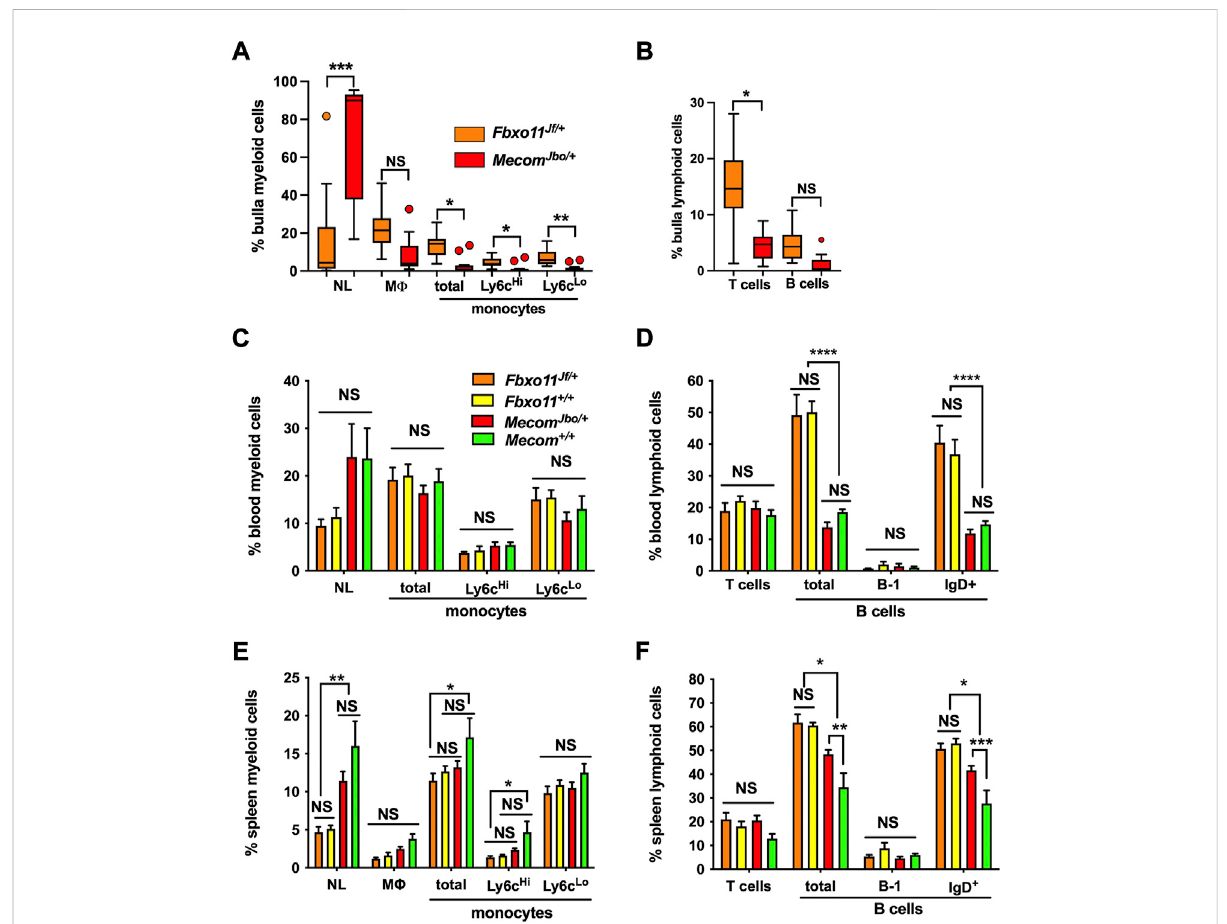
FIGURE 2 FACS analysis of bulla fl uid, blood and spleen WBC. (A,B) Bulla fl uids (C,D) blood and (E,F) spleen. (A) Bulla fl uids in Mecom Jbo/+ mice have a signi fi cantly higher percentage of neutrophils than Fbxo11 Jf/+ mice, whereas Fbxo11 Jf/+ mice have higher total monocytes, higher Ly6c Hi and Ly6c Lo monocyte subsets and (B) higher T cells than Mecom Jbo/+ mice. Data in A and B are for n = 14 Fbxo11 Jf/+ and n = 12 Mecom Jbo/+ bulla fl uids and are represented by box-and-whisker plots, with outlier vales represented by points, and analysed in a series of Kruskal – Wallis tests followed by Dunn ’ s multiple comparison tests (see statistical analysis for details). (C) Blood myeloid and (D) lymphoid cells. Within mouse strains, myeloid and lymphoid cells are not signi fi cantly different in Mecom Jbo/+ and Mecom +/+ comparisons, and in Fbxo11 Jf/+ and Fbxo11 +/+ comparisons. There were genetic background strain differences between Fbxo11 and Mecom leukograms; Fbxo11 mice had higher total B lymphocytes and IgD + B subset populations. (E) Spleen myeloid and (F) lymphoid cells. Within mouse strains, Mecom Jbo/+ mice had higher total splenic B lymphocytes and IgD + B subsets than Mecom +/+ mice. All other myeloid and T cells comparisons in Mecom Jbo/+ and Mecom +/+ , and in Fbxo11 Jf/+ and Fbxo11 +/+ were not signi fi cantly different. Genetic background strain differences include Fbxo11 mice having higher total B lymphocytes and IgD + B subset populations and Mecom mice have higher splenic neutrophils than Fbxo11 mice and Mecom +/+ mice have higher total monocytes and Ly6c Hi monocyte subsets than Fbxo11 Jf/+ mice (Figure 2E). Data in panels (C – F) are for n = 6 Fbxo11 Jf/+ , n = 6 Fbxo11 +/+ , n = 8 Mecom Jbo/+ , and n = 7 Mecom +/+ samples; the histogram bars represent mean and the error bar s.e.m. Blood and spleen WBC differentials were analysed in a series of two-way ANOVA ’ s with Tukey ’ s or Sidak ’ s multiple comparisons tests (see statistical analysis for details). Two-tailed tests: NS, not signi fi cant p > 0.05, * p < 0.05, ** p < 0.01, *** p < 0.001, **** p <